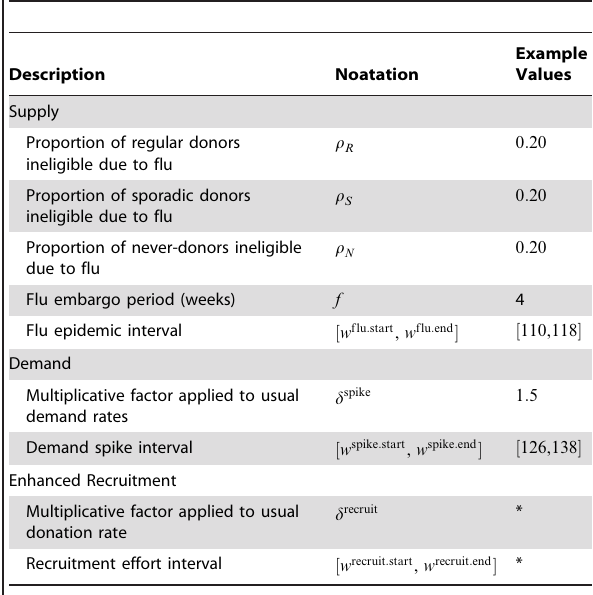
*: Refer to Table 3 for specific scenarios.